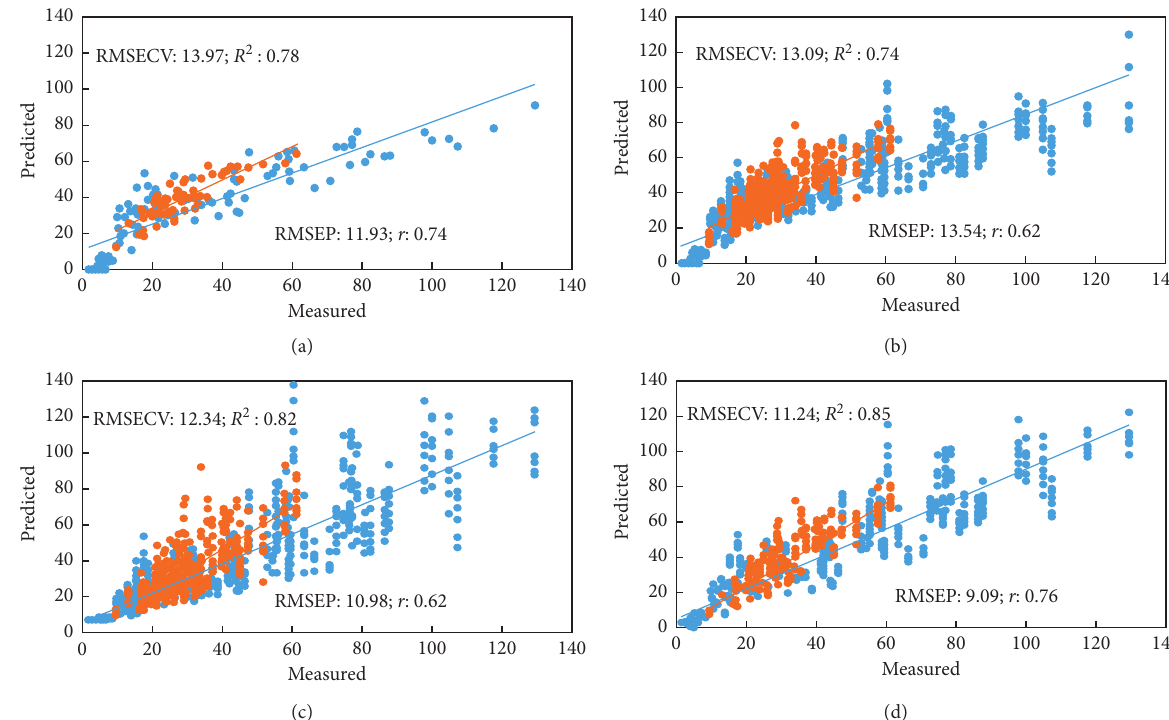
Figure 3: Measured vs. predicted scores of α -solanine (mg kg − 1 ) in the calibration (blue) and prediction (red) sets with PLS models using (a) Hunter’s a ∗ values; (b) Hunter’s a ∗ /b ∗ values; (c) (a ∗ /b ∗ ) 2 values; and (d) multivariate